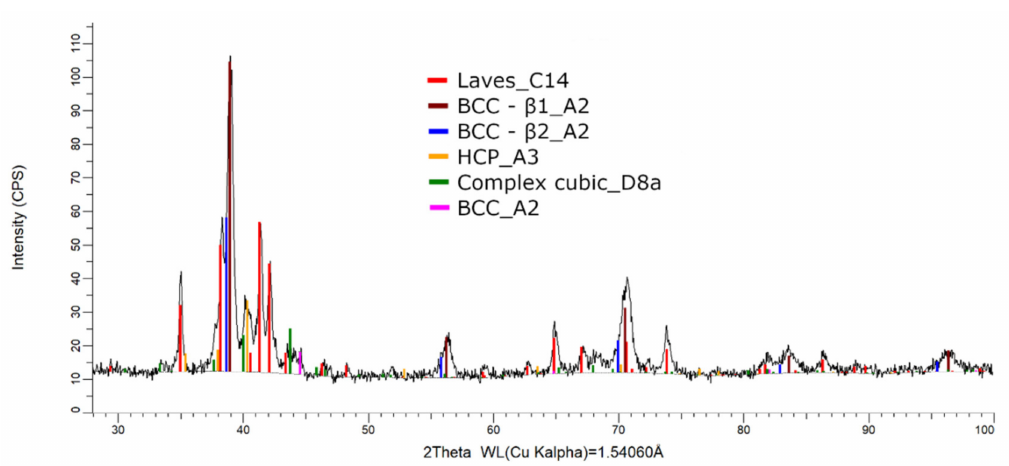
Figure 14. X-ray diffraction pattern for the remelted FeTa 0.5 Nb 0.5 Ti 1.5 Zr 0.5 alloy. The SEM analyses of the FeTa 0.5 Nb 0.5 TiZr 0.5 alloy revealed a dendritic structure (Figure 15) with larger branches than for the FeTa 0.5 Nb 0.5 Ti 1.5 Zr 0.5 alloy. According to